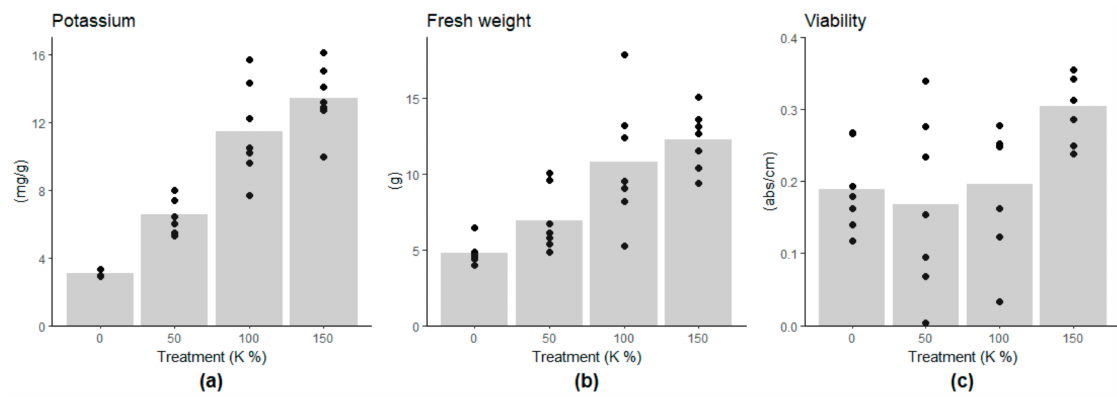
Figure 1. Effect of potassium treatments (0%, 50%, 100%, and 150%) on ( a ) intracellular potassium content per dry weight, ( b ) fresh weight and ( c ) viability of cells. The low potassium contents in the culture medium decreased the potassium content of the cells, which inhibited the growth linearly. Cell viability was higher in the 150% K treatment compared to the other